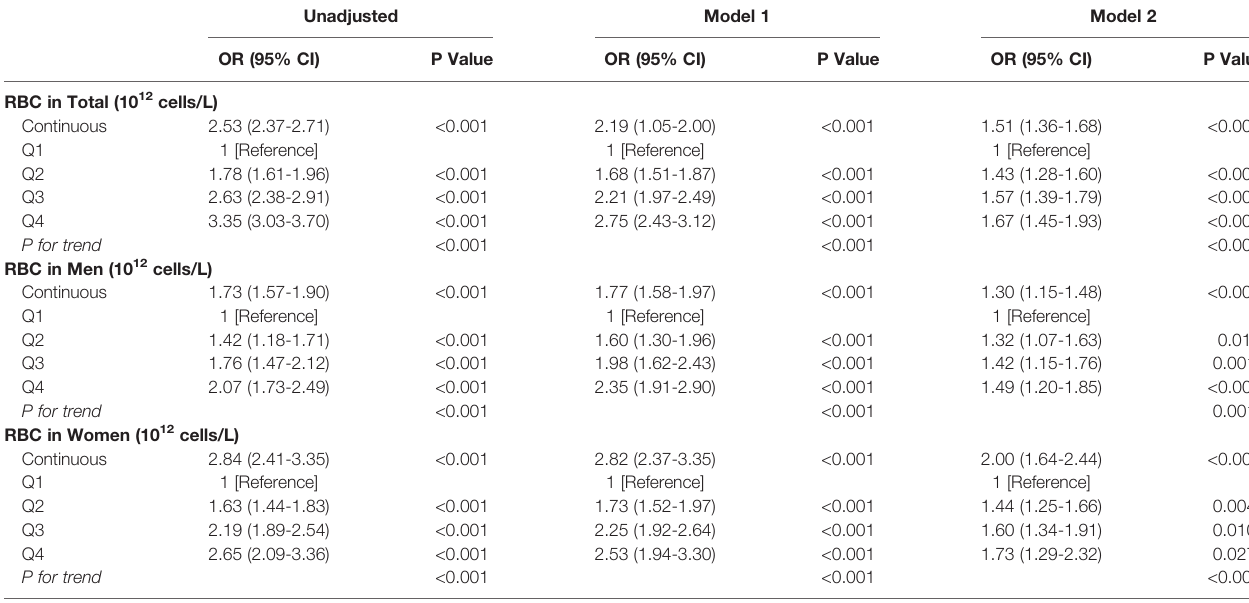
TABLE 2 | GEE analysis for severity of incident NAFLD based on RBC count during